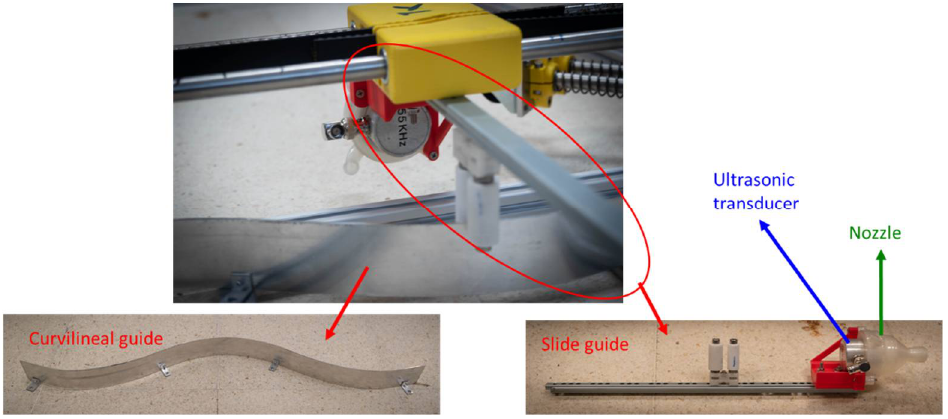
Figure 10. Guide system to inspect the shaft.